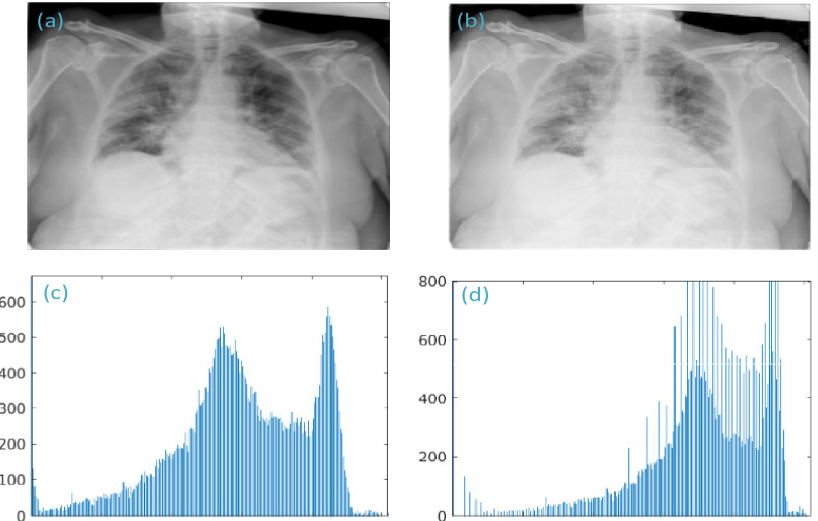
Figure 2. Enhancement of X-ray image ( a ) original image ( b ) gamma correction image ( c ) histogram of original image ( d ) histogram of gamma correction.